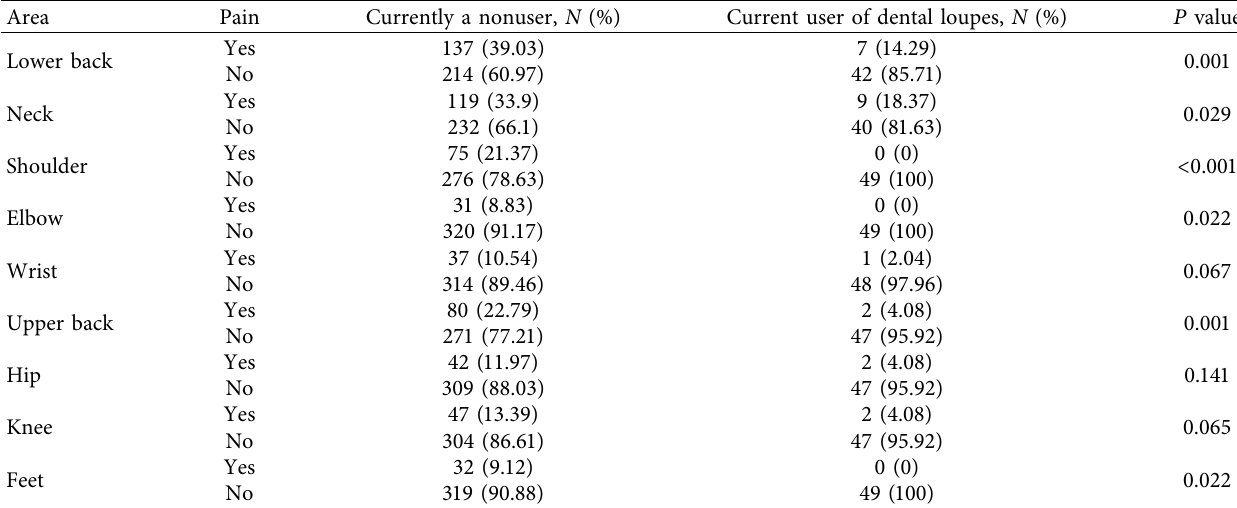
Table 6: The relationship between current and nonusers of dental loupes and a history of recent musculoskeletal trouble in the previous seven days.